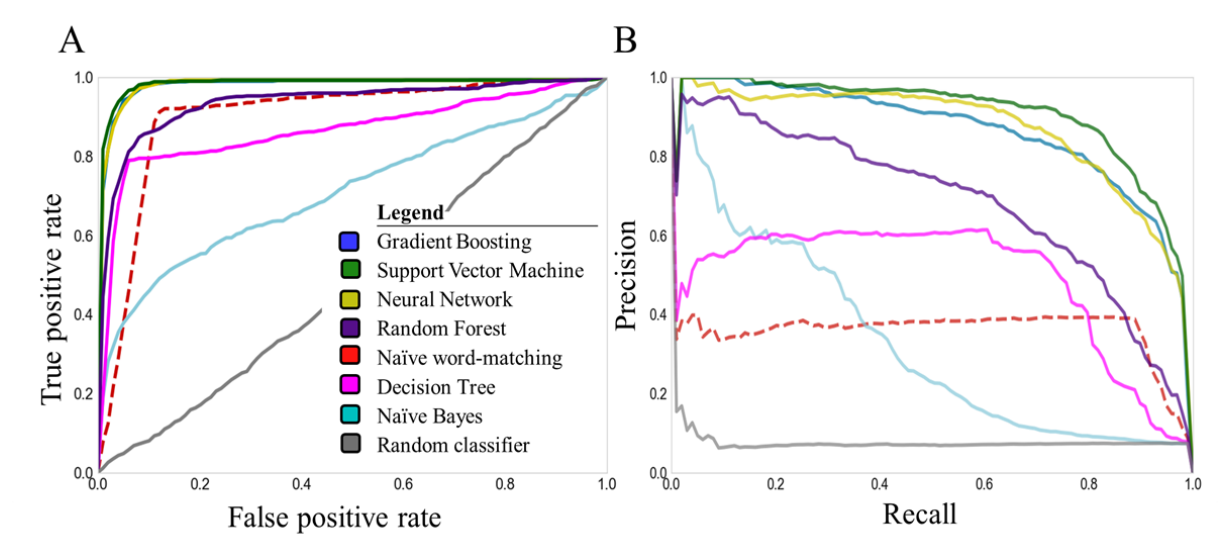
Figure 2. (A) Receiver operating characteristics and (B) precision-recall curves for all machine learning methods (solid lines) and the naïve word-matching method (dotted line) in the training set